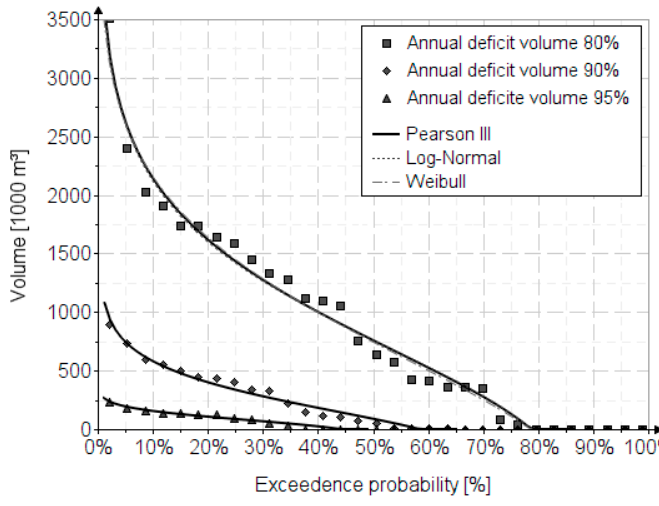
Figure 9 shows the frequency curves used for the annual deficit volumes corresponding to the thresholds of 95%, 90% and 80%.